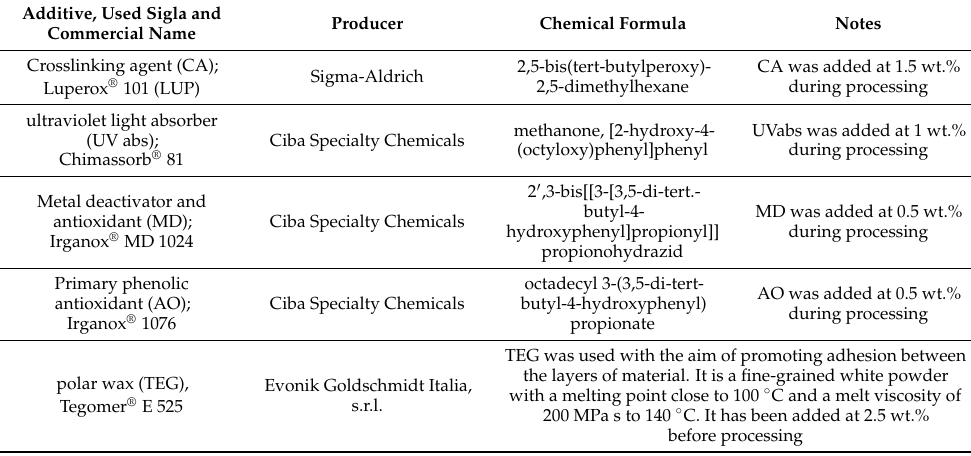
Table 1. Commercial name, producer and chemical formula of used